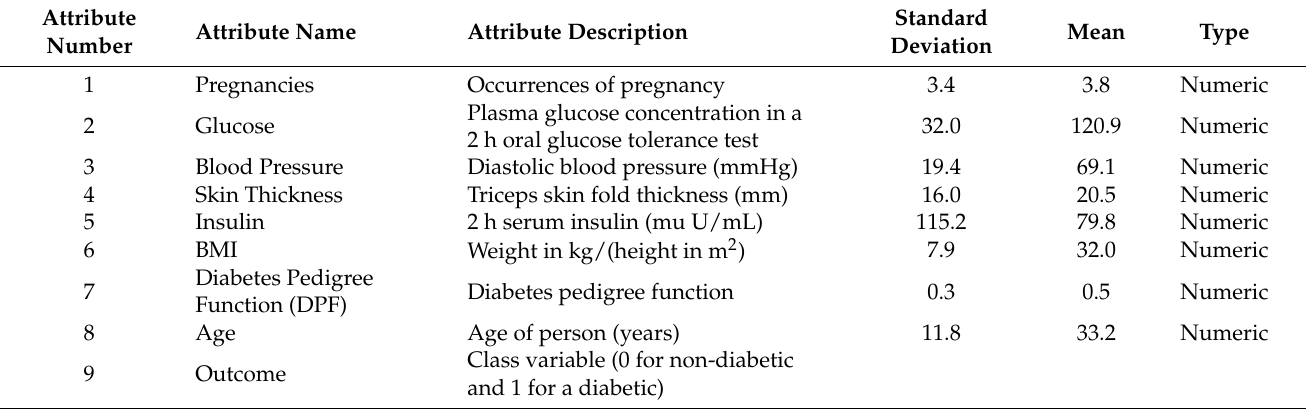
Table 1. PIDD Dataset Description and